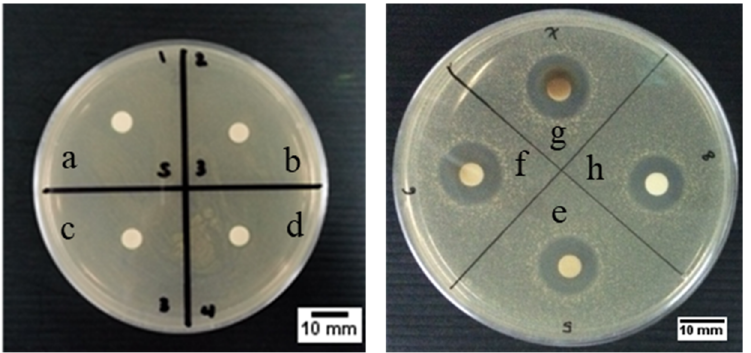
Figure 8. The representative of antibacterial testing result using the disc diffusion method of ( a ) extract of baked Cilembu sweet potatoes, powder of: ( b ) Baked 1, ( c ) Baked 10, ( d ) Baked 100. Colloidal sample of: ( e ) Baked 1, ( f ) Baked 10, ( g ) Baked 100 and ( h ) Unbaked 10. Table 2. Antibacterial results of samples from disc diffusion